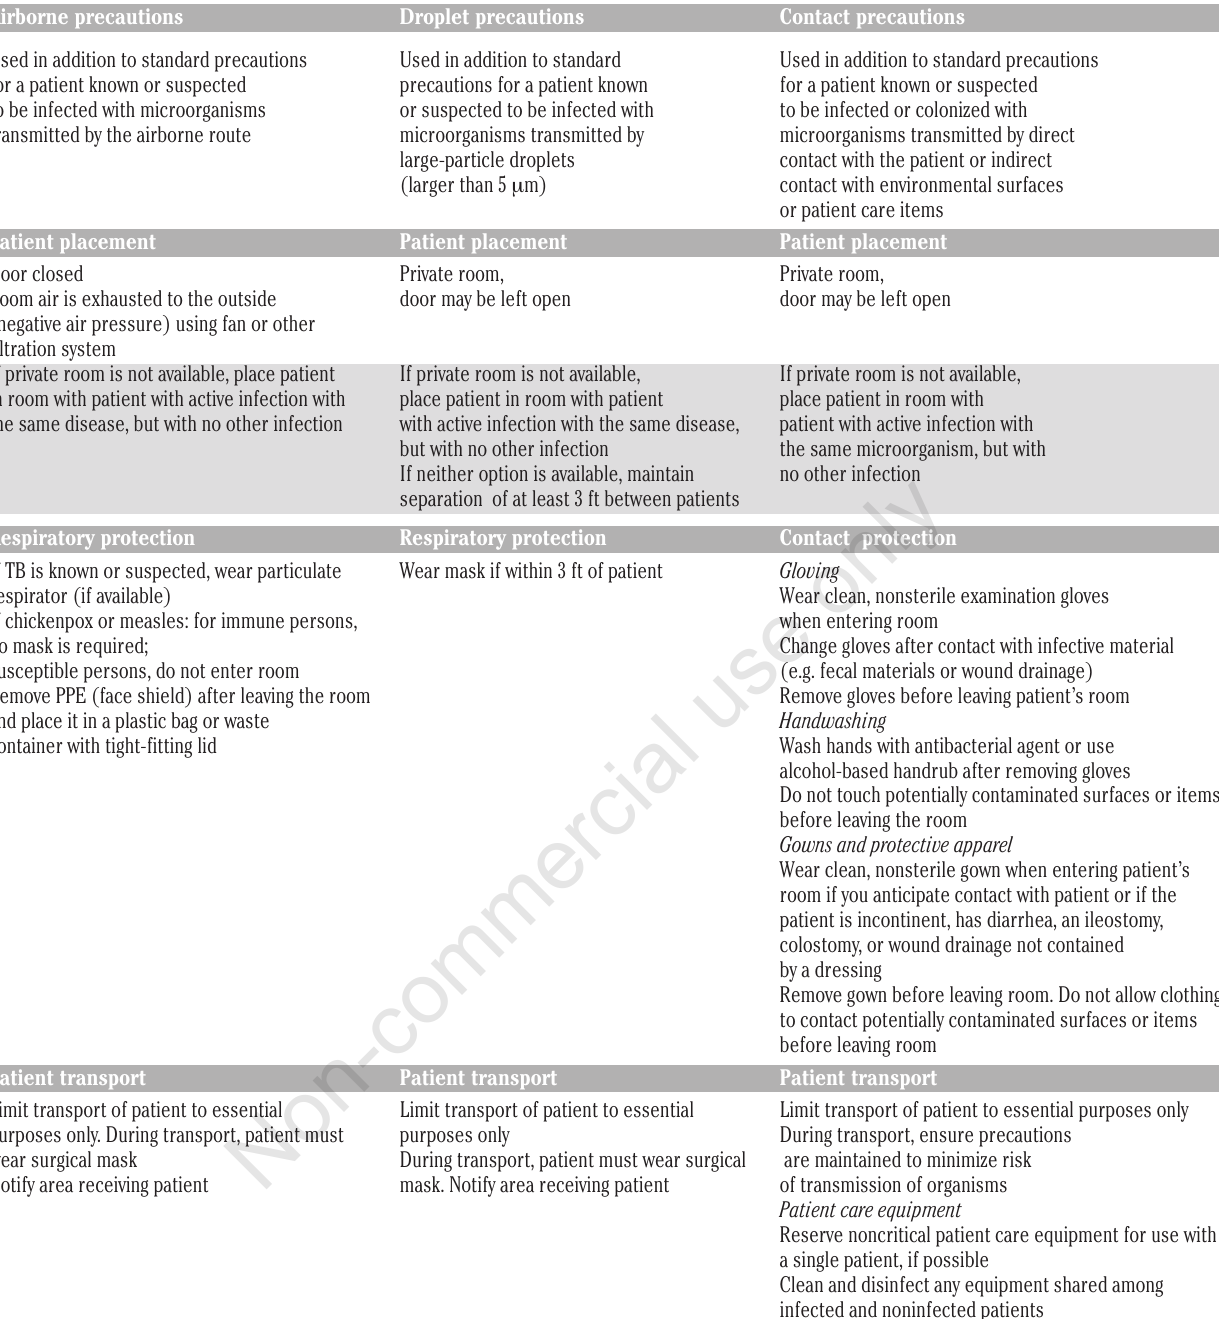
Table 2. Transmission-based precautions are used when the route(s) of transmission is(are) not completely interrupted using standard precautions alone.* Airborne precautions